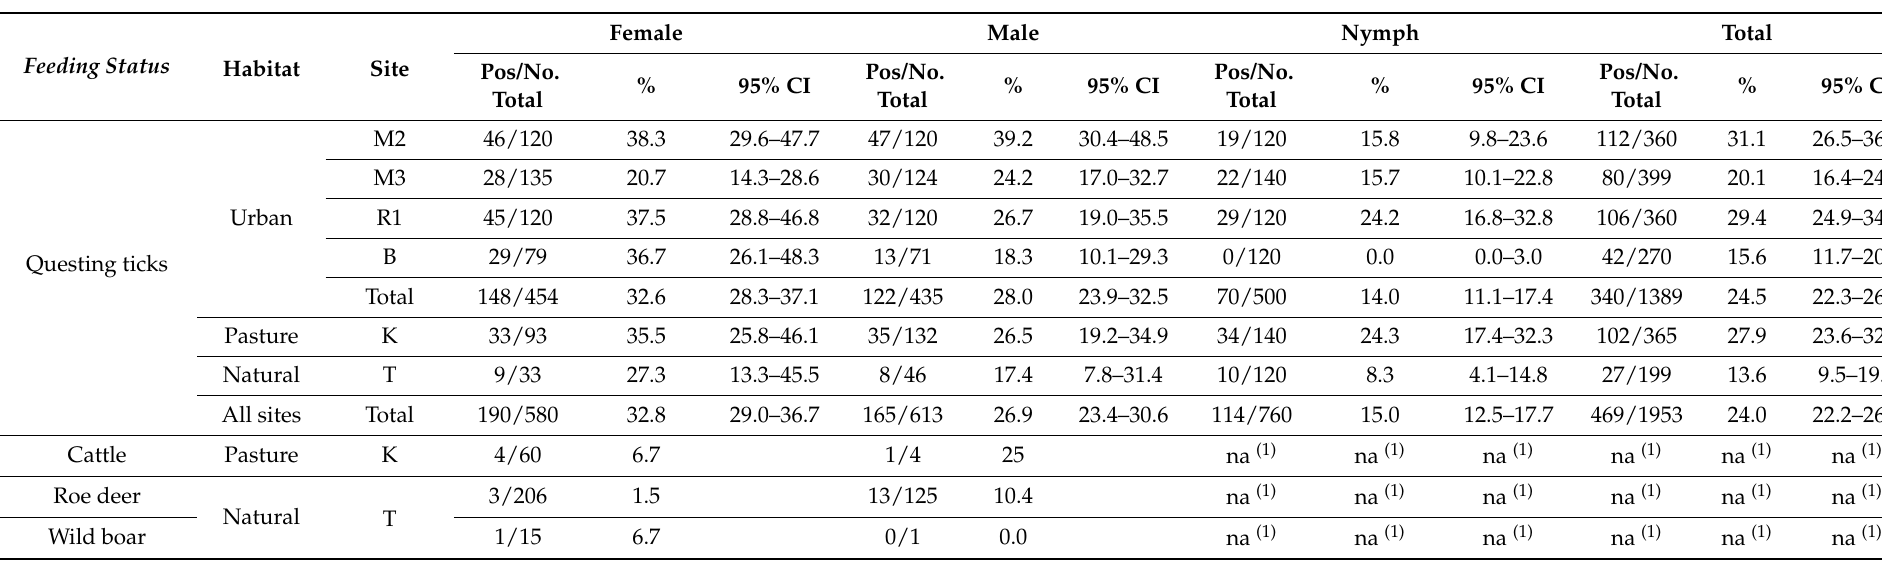
Table 1. Prevalence of Borrelia burgdorferi sensu lato in questing and engorged Ixodes ricinus ticks (collected from roe deer, wild boar, and cattle) per gender, stage, site, and habitat.